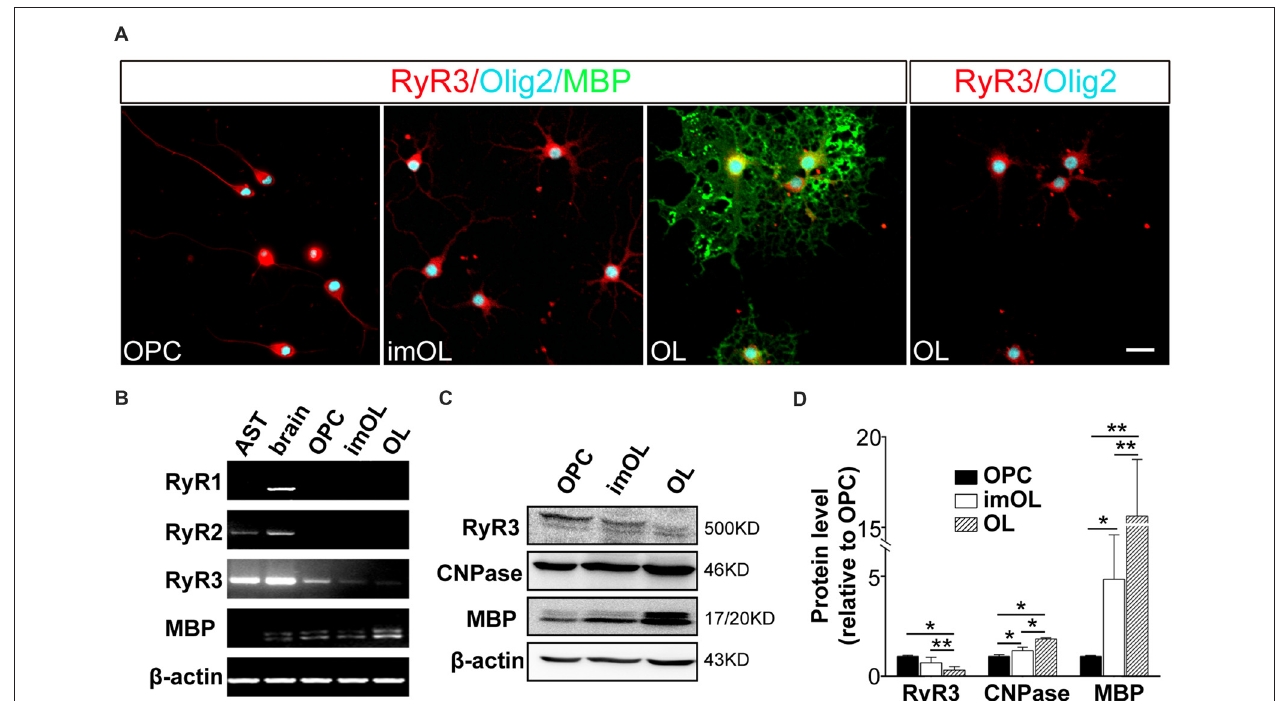
FIGURE 1 | Oligodendroglial cells selectively express ryanodine receptor 3 (RyR3), which is downregulated during differentiation. (A) Immunofluorescence staining of RyR3, Olig2 (oligodendroglial lineage marker) and myelin basic protein (MBP; mature OL marker) in three stages of cultured OL lineage cells. RyR3 was strongly distributed all over the cytoplasm and processes in oligodendrocyte progenitor cells (OPCs) and immature oligodendrocytes (imOLs), while in mature OLs, RyR3 signal was mainly located in the cell body and showed lower expression in the primary processes. Scale bar 20 µ m. (B) mRNA levels of RyRs in OL lineage cells, astrocytes (AST) and rat brain tissue. (C,D) Western blot analysis showed increased levels of myelin proteins (CNPase, MBP) and decreased levels of RyR3 protein during OPC development ( ∗ p < 0.05, ∗∗ p < 0.01).